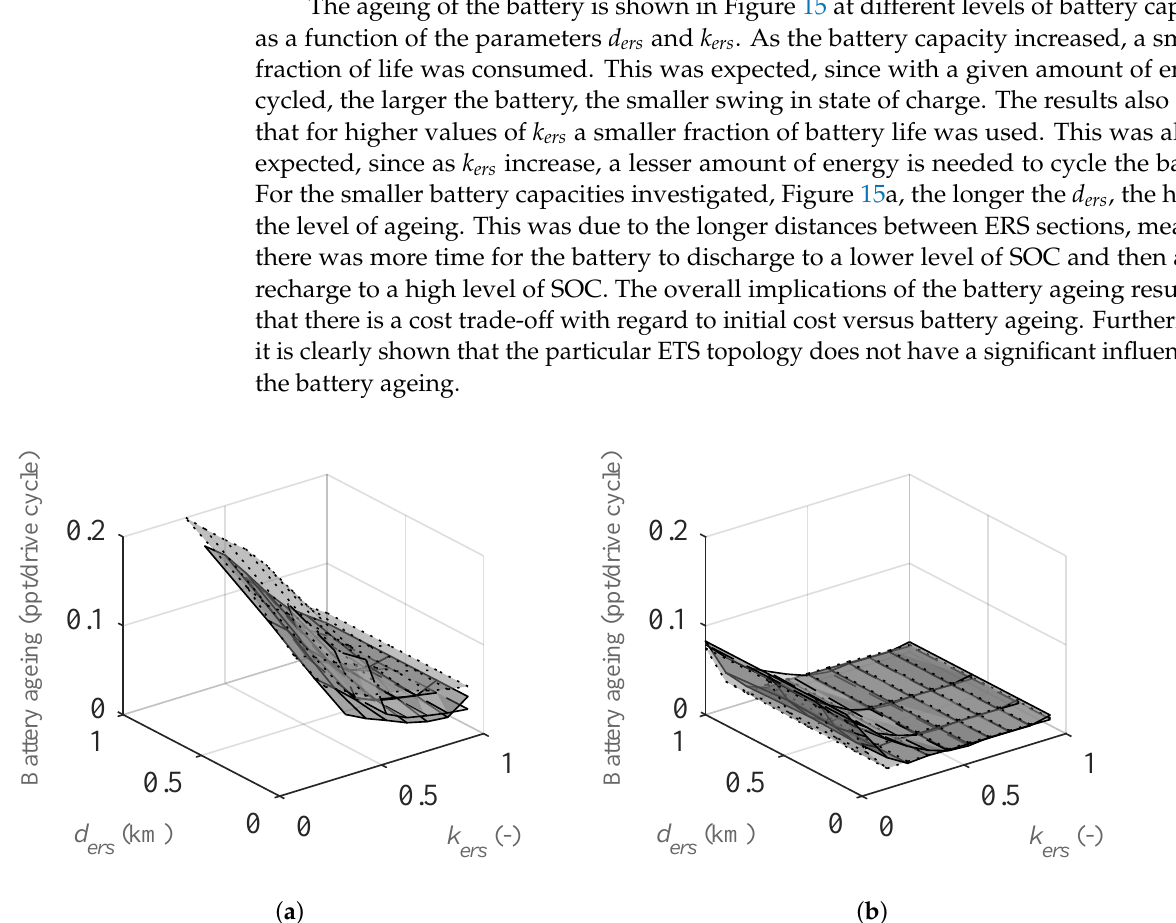
Figure 15. Battery life consumed (‰/drive cycle) of a city bus on “City bus route 85” as a function of the distance between ERS sections, d ers , and the ratio of ERS-coverage, k ers . The subfigures represent a specific amount of battery capacity; ( a ) 70 kWh, ( b ) 300 kWh. The dashed lines and light grey surface represent the LSETS; the area with dots and light grey − − is the HSETS; and the dark grey area is the